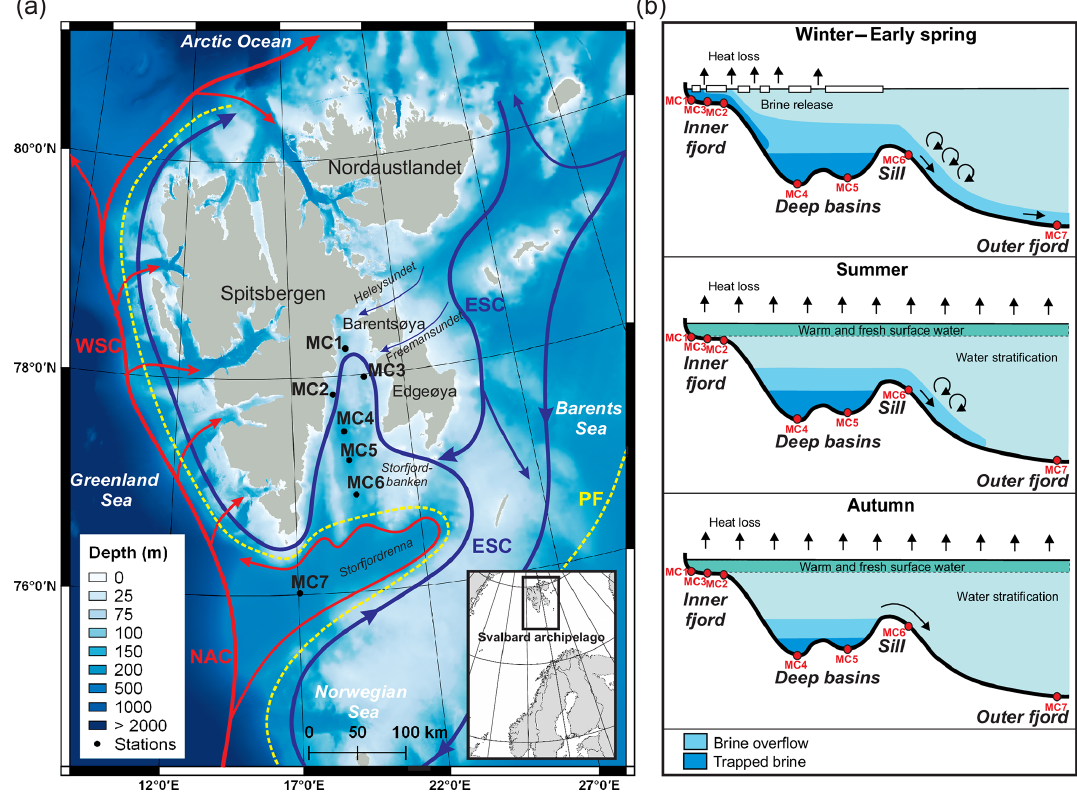
Figure 1. (a) Bathymetric map showing the main current circulations around the Svalbard archipelago (currents from Skogseth et al., 2005b and Misund et al., 2016) and locations of the sampling stations. The red lines represent the warm North Atlantic waters carried by the Norwegian Atlantic Current (NAC) and West Spitsbergen Current (WSC). The blue lines represent the cold Arctic waters carried by the East Spitsbergen Current (ESC). The dotted yellow line represents the polar front (PF). Bathymetry was obtained from EMODnet (http://portal.emodnet-bathymetry.eu, last access: 24 January 2019), and the map was elaborated with QGIS (made with Natural Earth). (b) Longitudinal bathymetric profile sketches showing seasonal formation and flow of brine in inner and outer Storfjorden (modified from Skogseth et al., 2005a and Rasmussen and Thomsen, 2015) and the indicative location of the sampling stations (red